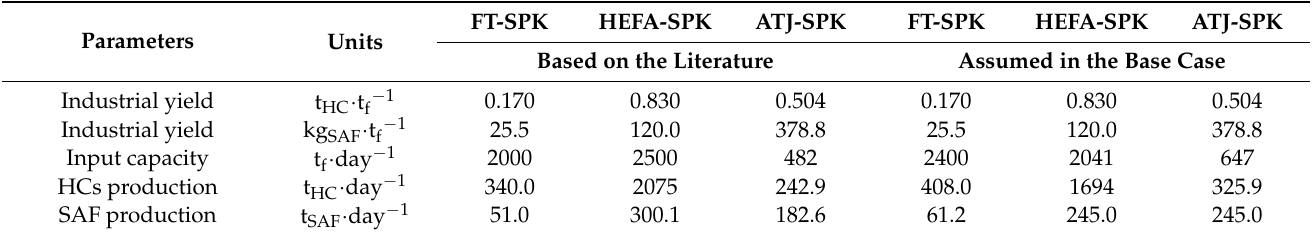
Table 2. Assumed technical parameters for the SAF production unit based on the literature and those considered in the base case—t f refers to tonnes of the feedstock on a dry